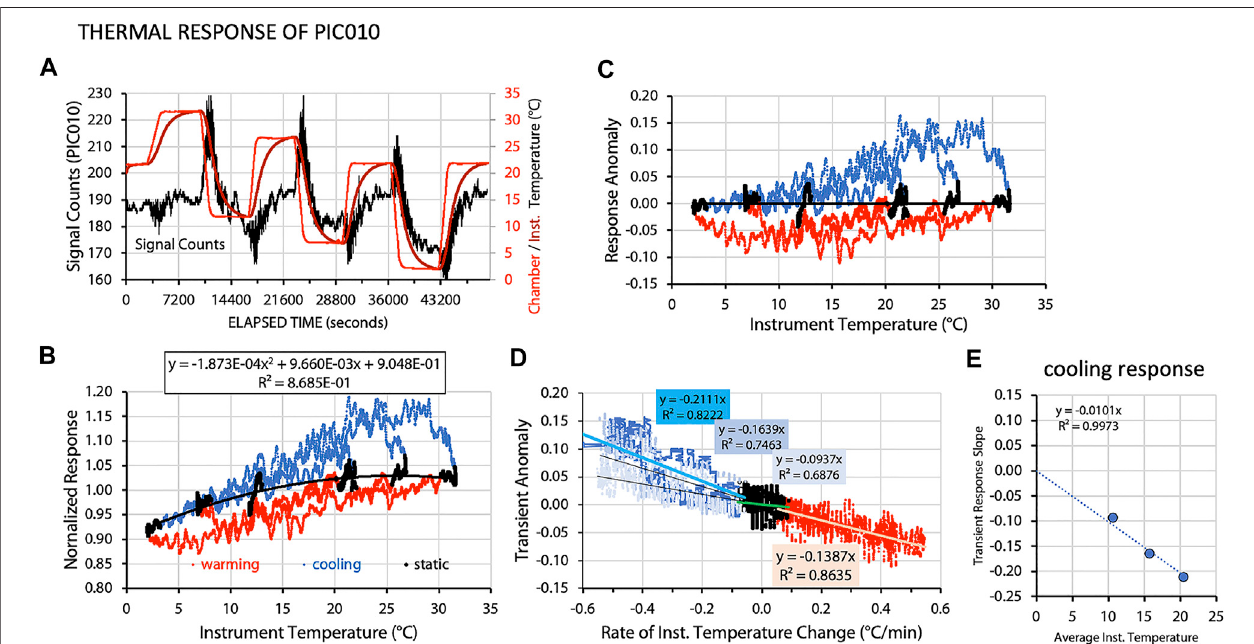
FIGURE 4 | (A) Time series of the digital output from PIC010 during a thermal cycling experiment over 14 h. During the experiment, chamber temperature was cycled over a temperature range from 32 to 2 ° C. Instrument temperature lagged chamber temperature. During periods of strong cooling, the sensor displays a positive transient;similarly,duringperiods ofwarming, thereisanegative transient. (B) Thenormalized signal countsforperiods ofwarming, cooling,andduring periodsofstatic temperature.Theregressiondataare fi ttothedataduringthermalequilibriumofchamberandinstrument. (C) Datafrom (B) afterremovalofthestaticthermaltrend. (D) Plots of residual anomaly vs rate of instrument temperature change. In (B – D) , red and blue colors denote data during instrument warming and cooling. Data during thermal equilibrium are shown in black. (E) Temperature dependence of transient response.